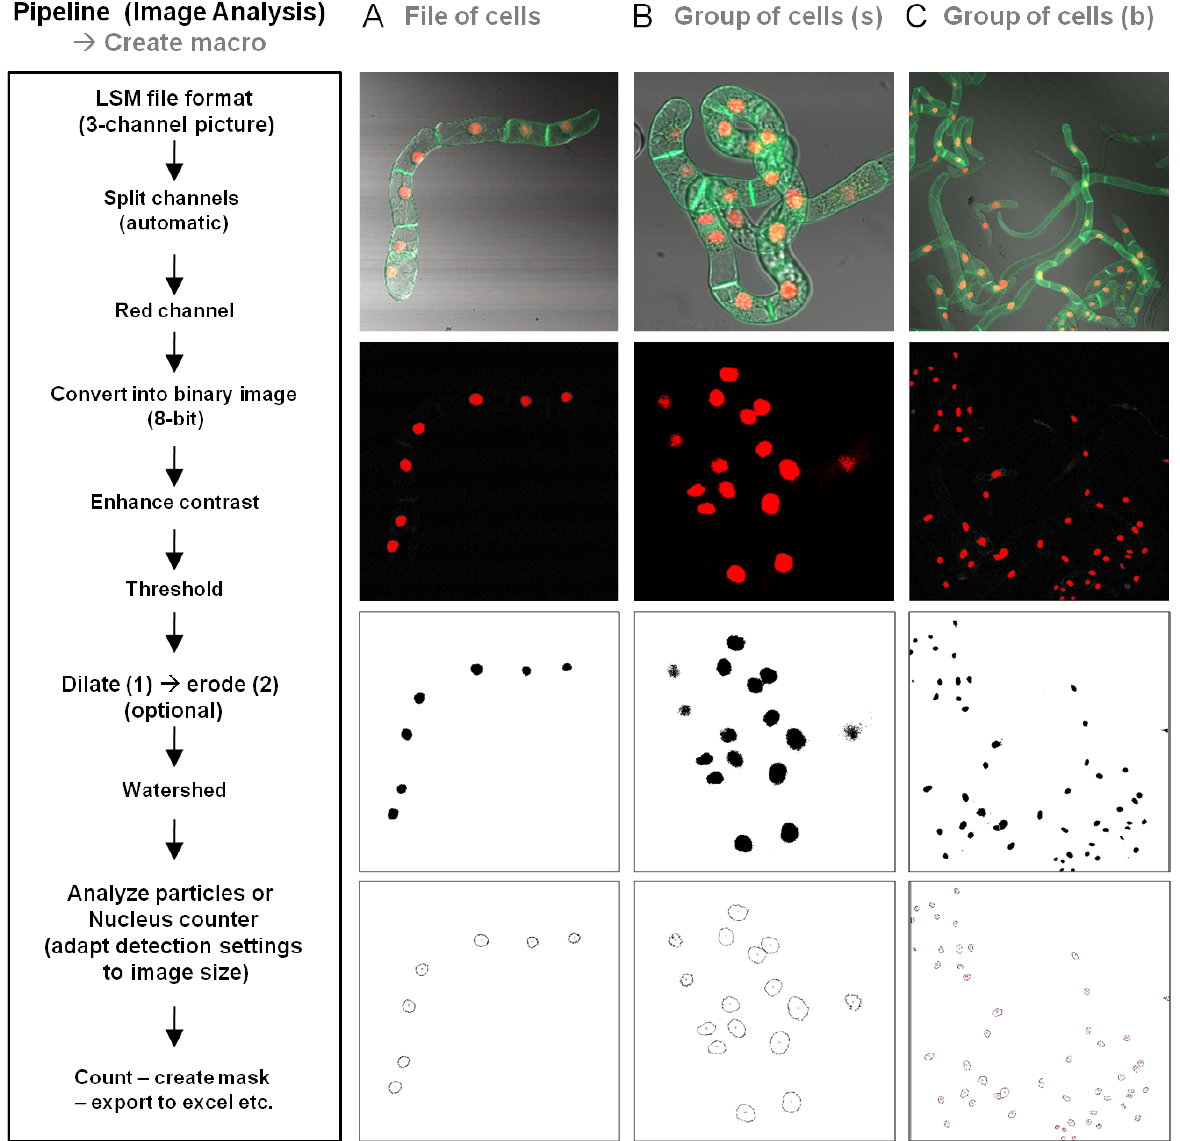
Figure 12. Use of the mRFP fluorescence (red channel) to detect and count BY-2 cells. The flow of actions to be taken is shown left, and corresponding images and their conversion for particle counting is shown for A ) a file of cells, B ) a group of cells at higher magnification, and C ) at lower